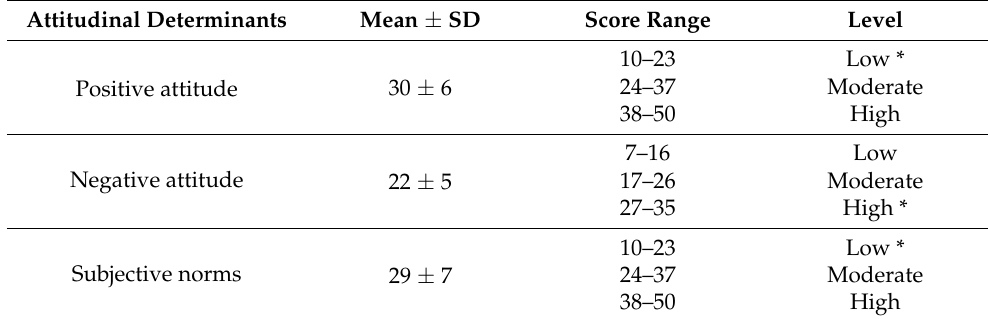
Table 2. Attitude towards plagiarism score and its interpretations of levels.